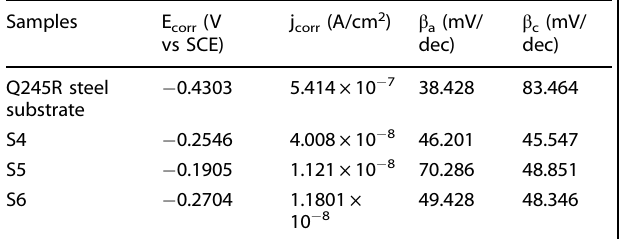
Table 5. The corresponding self-corrosion potential, corresponding self-corrosion current density, β a , and β c , of Q245R steel substrate and Inconel 625 coatings: S4, S5, S6.